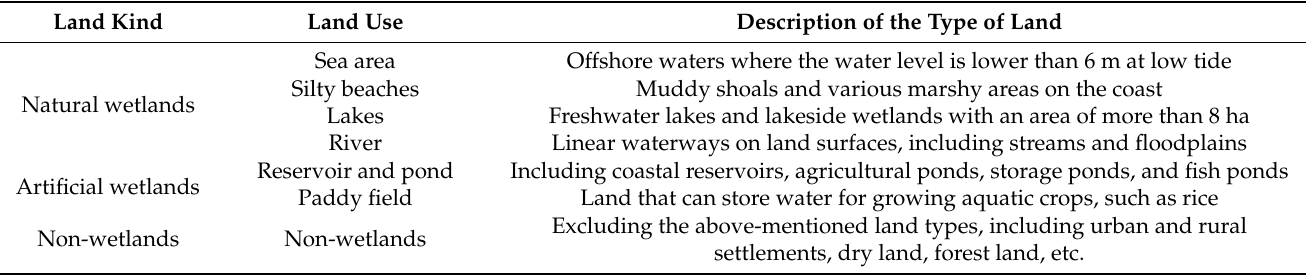
Table 1. Details of wetland classification